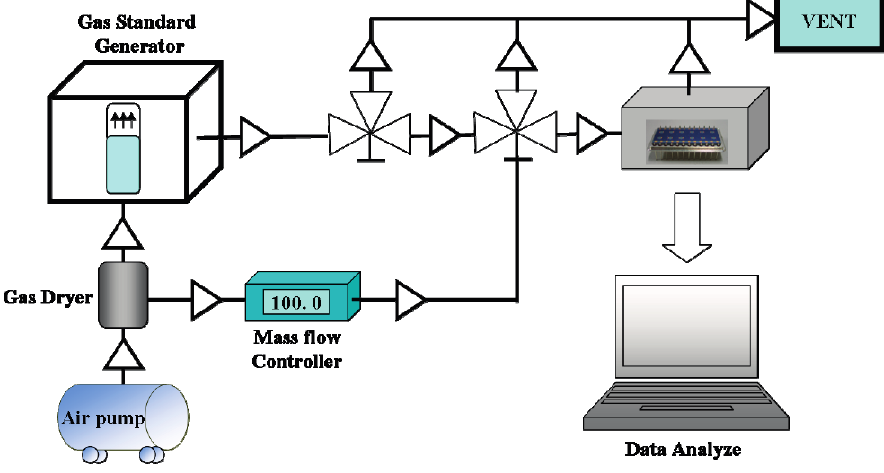
Figure 2. Experimental setup used to characterize the sensing volatile organic